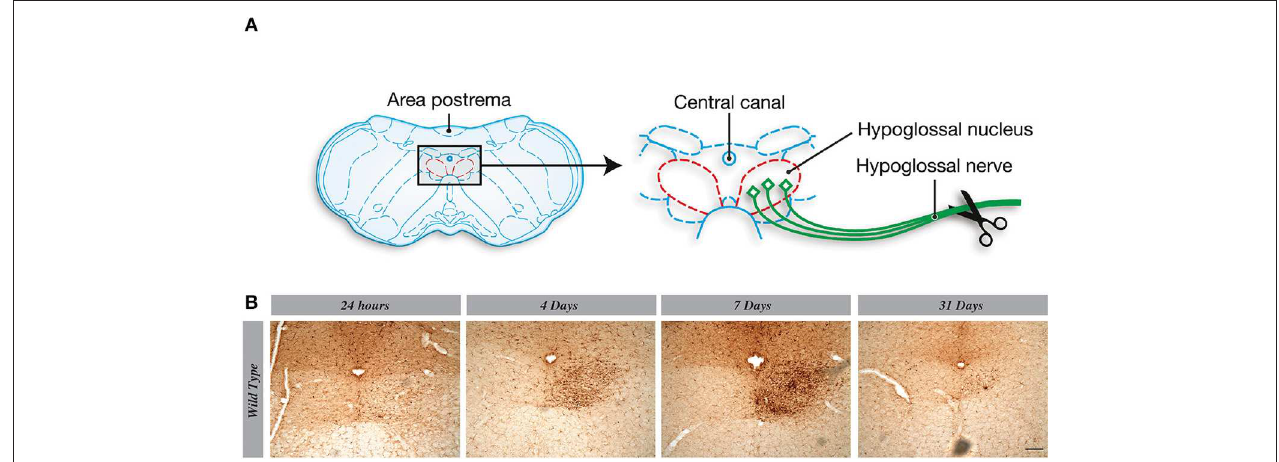
FIGURE 2 | Microglial proliferation in hypoglossal nucleus is maximal 7 days after the lesion. (A) Scheme of hypoglossal nerve transection surgery. (B) A progressive increase of Iba1 staining is observed from 24h to 7 days post axotomy, which declined at 31 days. n = 3 mice. Scale bar: 100 µ